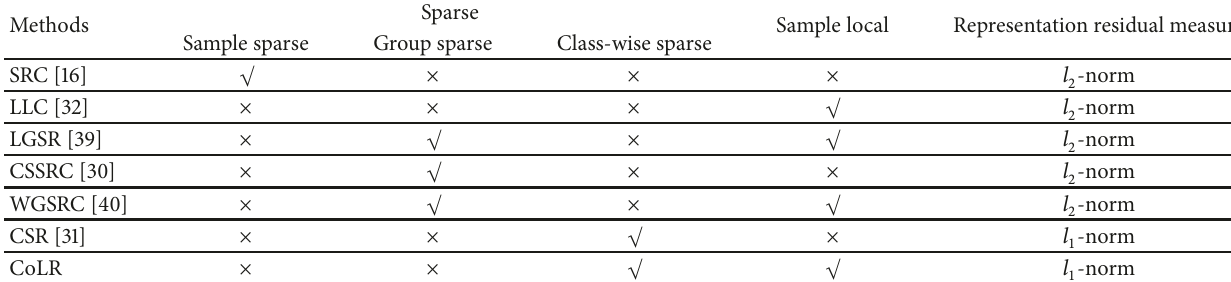
Table 1: A comparison between several representation-based learning methods.